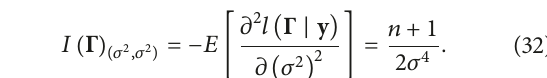
based on different parameter specifications. Figure